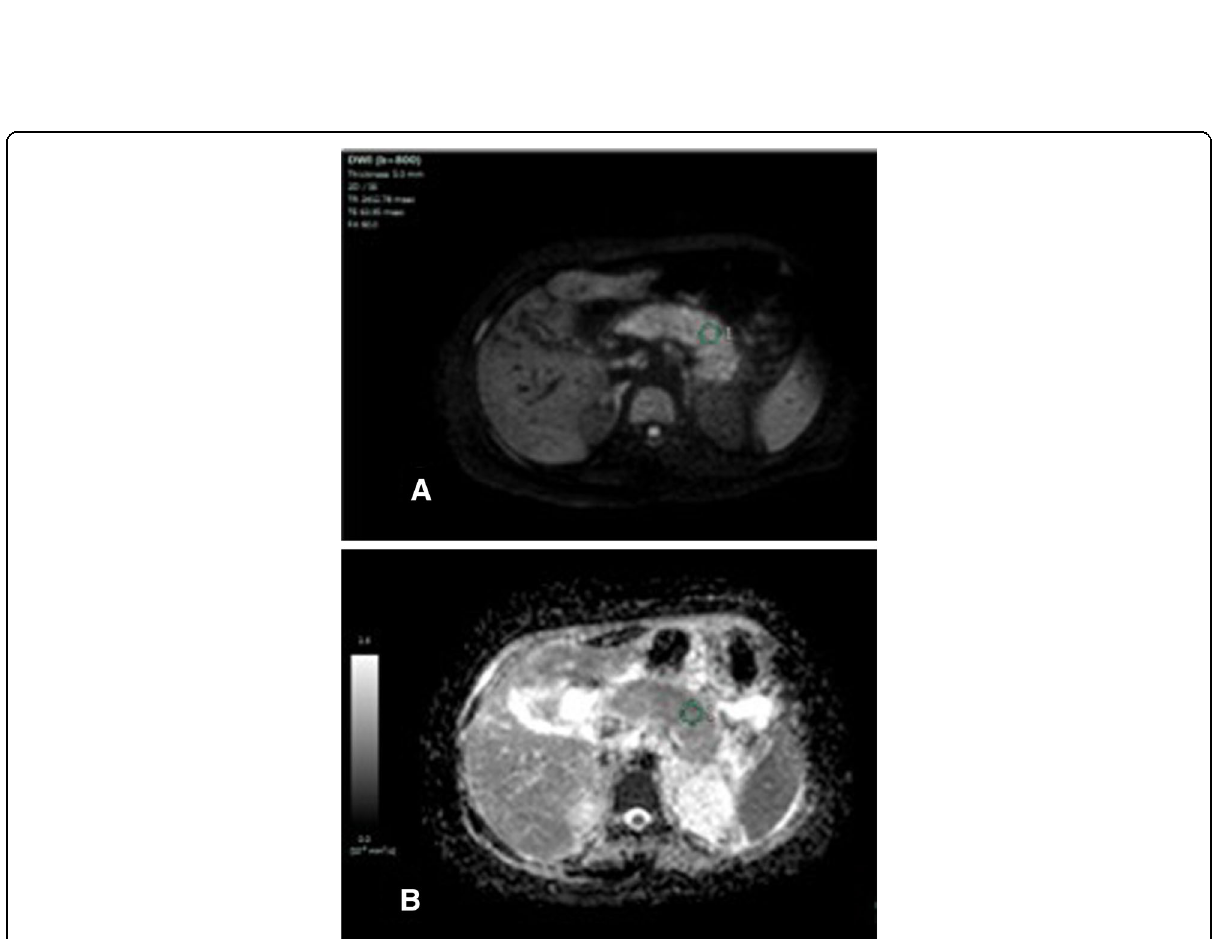
Fig. 7 DWI showing restricted pancreas and low ADC value of pancreatic body on ADC map 0.87 × 10 − 3 mm 2